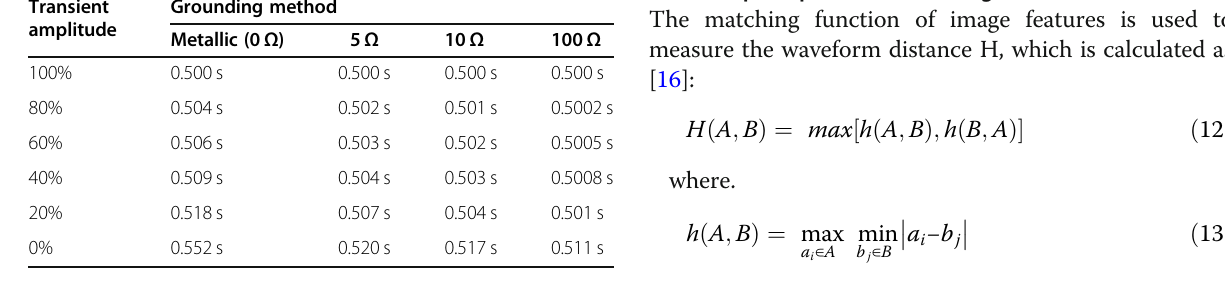
Table 2 Transient attenuation process Transient Grounding method amplitude